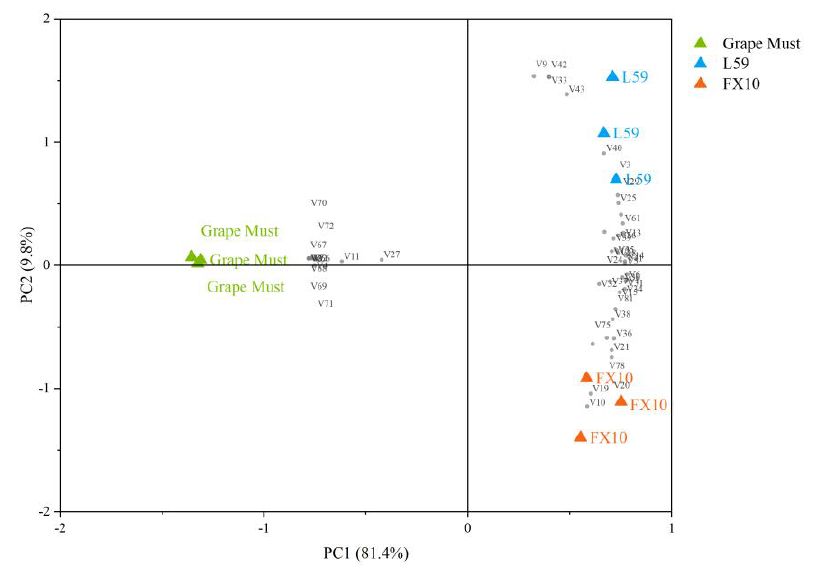
Figure 3. Principal component analysis (PCA) biplots of volatile compounds in Prince grape must and wines. Note: Volatile compound codes are provided in Table S1.